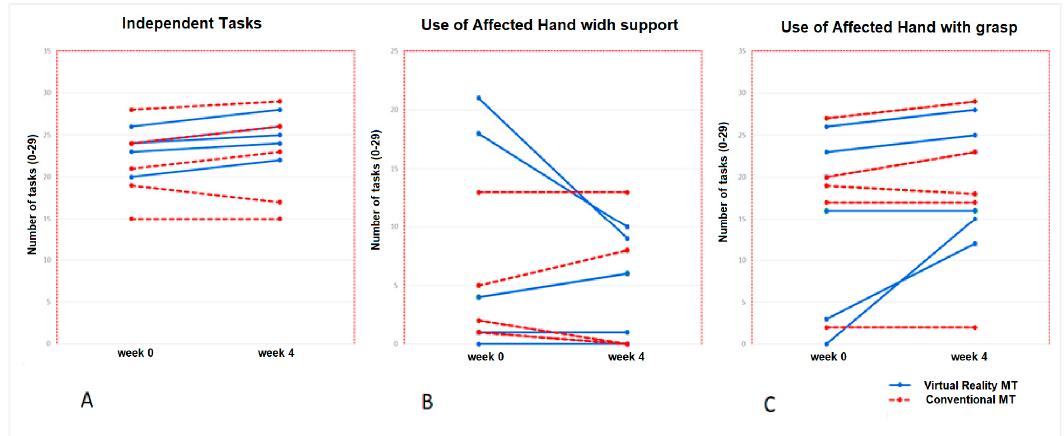
Figure 4. Progression of the number of tasks performed with the participation of the affected hand in Virtual MT and Conventional MT in the ten participants who completed the therapies (pre-post-treatment). Picture ( A ): Independent tasks; it shows an increase in all five children of the Virtual Reality MT group, but not in 2 children of the Conventional MT group. Picture ( B ) shows a great decrease in the use of the affected hand with support in 2 children of the Virtual Reality MT, which would coincide with the increase in the use of the affected hand with grasp for these children in the Virtual Reality MT group (Picture ( C )).